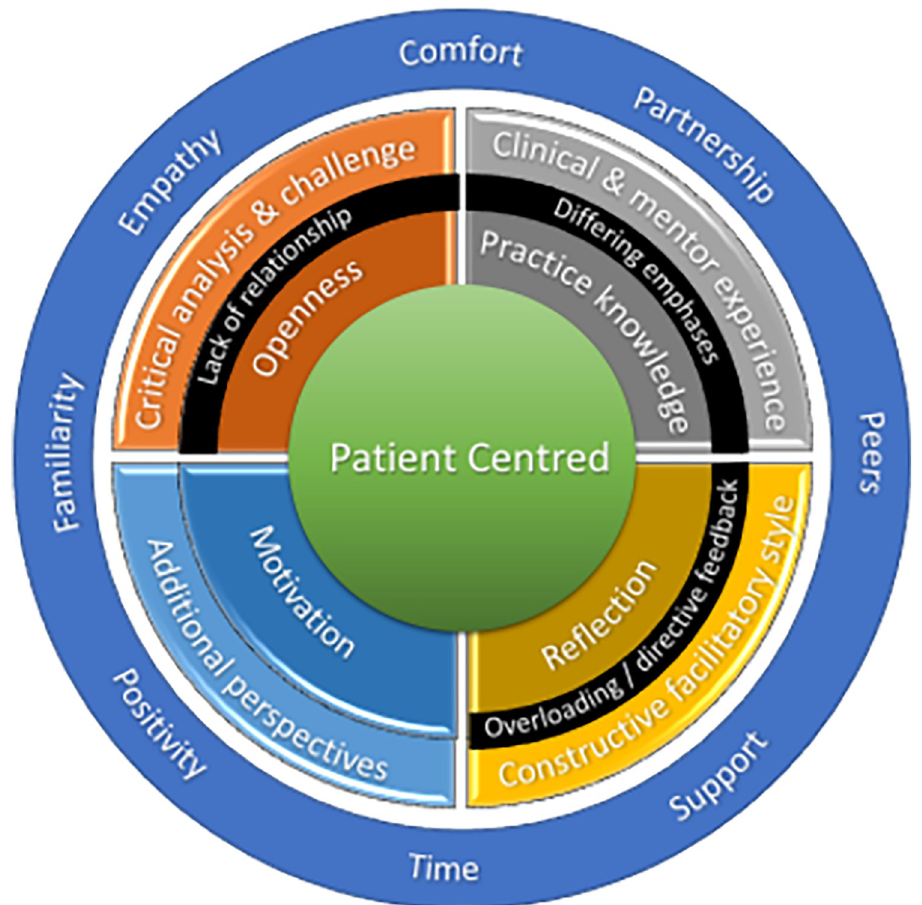
Fig 6. Mentor barriers to the emergent model of